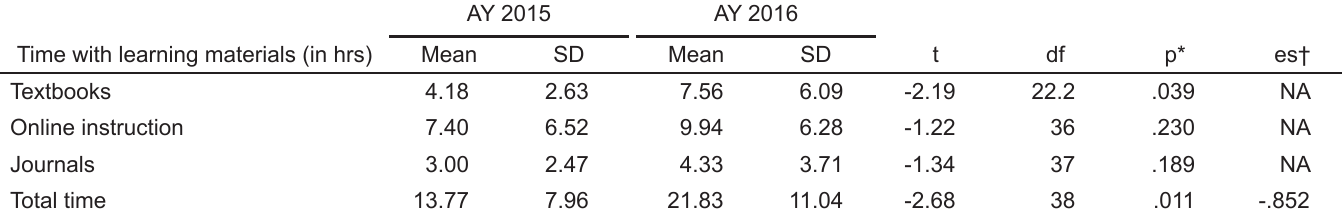
Table 3. Estimates of time spent with learning materials from 22 residents in academic year 2015 (lecture-based curriculum) and 18 residents from academic year 2016 (flipped-classroom